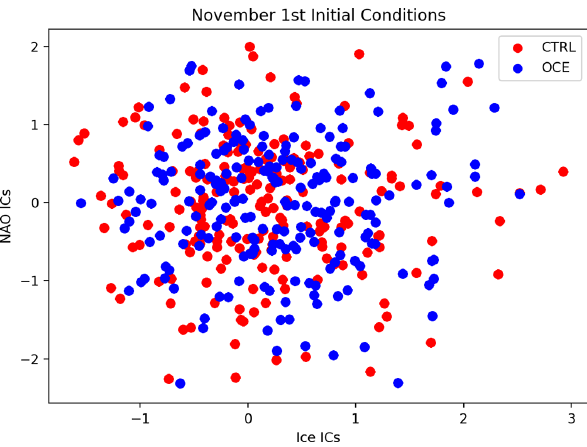
Figure B8. Scatter plot of the ice and NAO initial conditions, i.e. the values of the BKS sea ice ( x axis) and NAO anomalies ( y axis) on 1 November, for every year between 1980 and 2015. In red: CTRL; in blue: